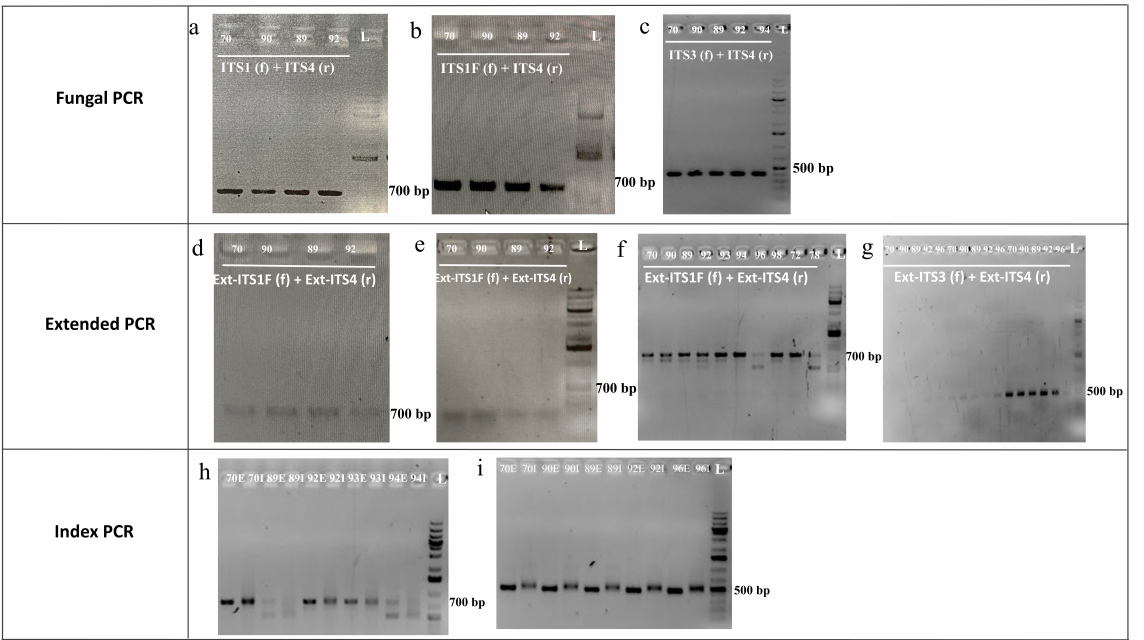
Figure 3. Gel images illustrating PCR optimization steps (Table 2), including test of primer function related to Figure 1. Numbers in the gell’s wells refer to sample numbers from the aspen TanAsp- collection [18]. L = Ladder, indicates fragment size in number of base pairs (bp). Desired fragments of length of 500–700 bp were found for ( a , b ), and fragments of length of 250–400 bp were found for ( c ). Weak bands were obtained for ( d ) and ( g , first nine wells). Dimers (the result of primer hybridization) were found for ( d , e ). Undesired fragments of length of 400–500 bp were found for ( f , h ). Desired fragments from extended PCR were found for ( g , last five dark bands). Desired fragments ( g ) and index PCR fragments were compared with ( i